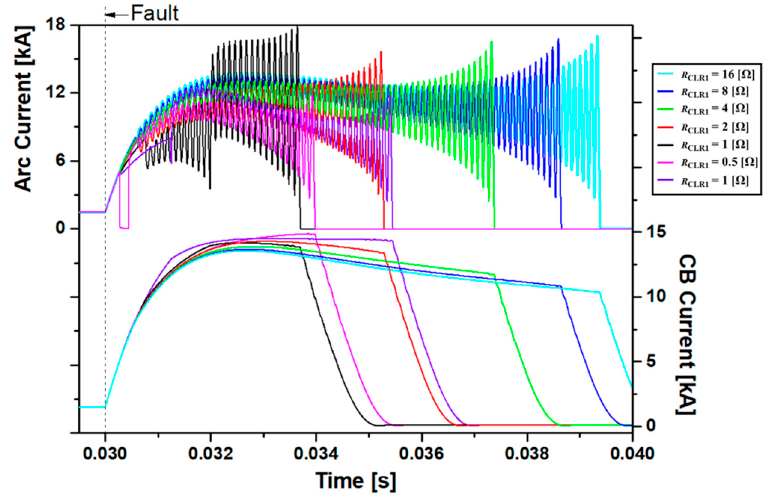
Figure 9. The waveform of DCCB current ( i DCCB ) and arc current ( i arc ) in the case where CLR1 resistance is 0, 0.5, 1, 2, 4, 8, 16 ( Ω ) and CLR2 is set to Inductance 3 (mH).